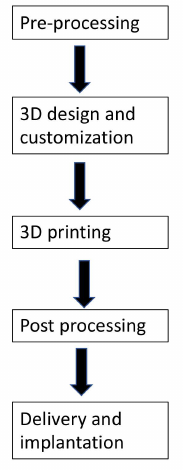
Figure 1. Steps for a 3D-printed